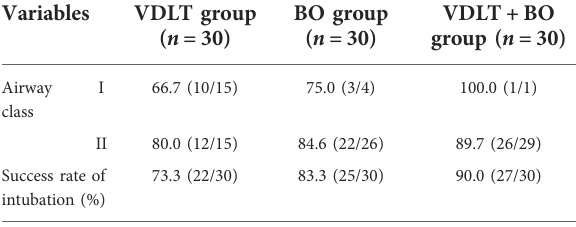
TABLE 4 Comparison of hemodynamic parameters before and after